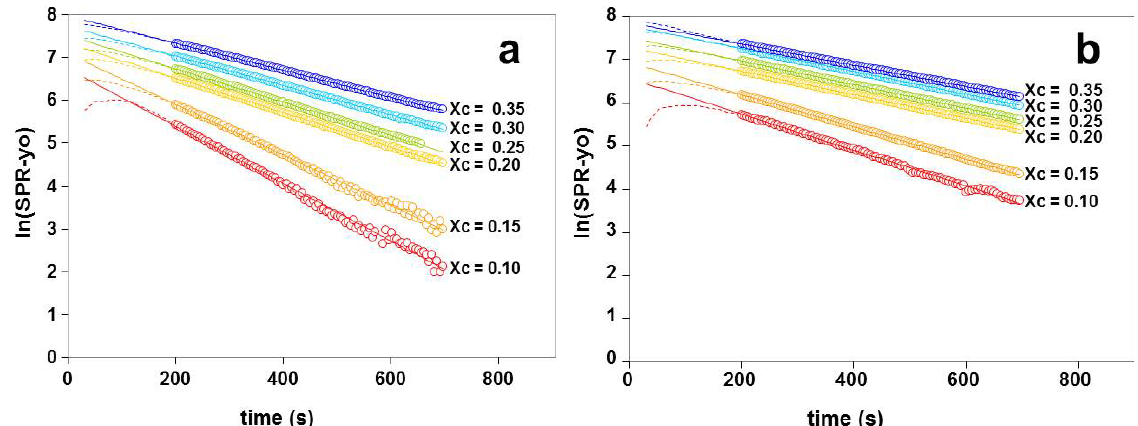
Figure 5. Demonstration of single exponential fits for removal of cholesterol from ( a ) POPC/cholesterol liposomes and ( b ) OPPC/cholesterol liposomes. For the POPC/cholesterol liposomes, the correlation coefficients for linear fits are 0.9999, 0.9996, 0.9996, 0.9997, 0.994, 0.993 for χ values of 0.35, 0.3, 0.25, 0.2, 0.15 and 0.1, respectively; C for the OPPC/cholesterol liposomes, the values are 0.9999, 0.9998, 0.9999, 0.9999, 0.9998 and 0.997 for the same sequence. Open circles indicate data used for linear fit; dashed lines indicate data outside region used for calculations; solid lines indicate linear